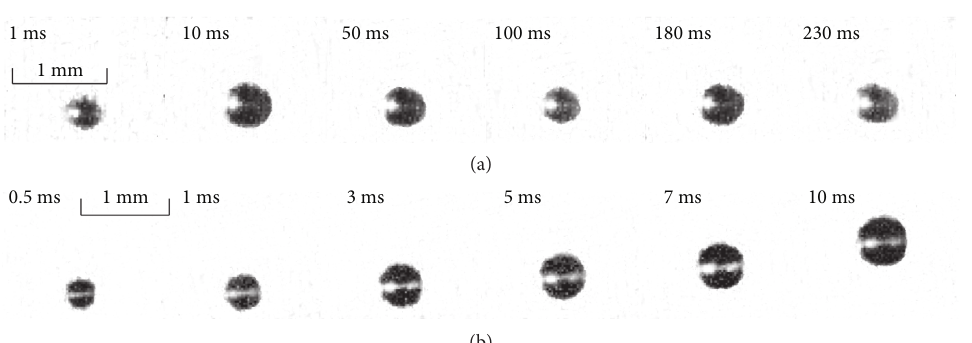
Figure 4: The bubble in channel a and channel b. (a) T